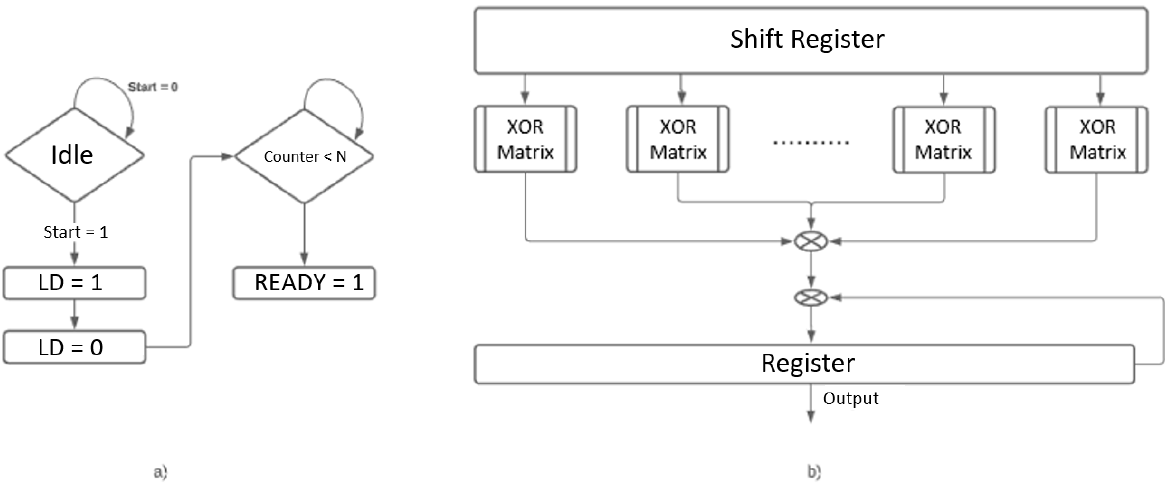
Figure 7. ( a ) FSM of the architecture and ( b ) Implementation of the Slicing-by-N computation unit.